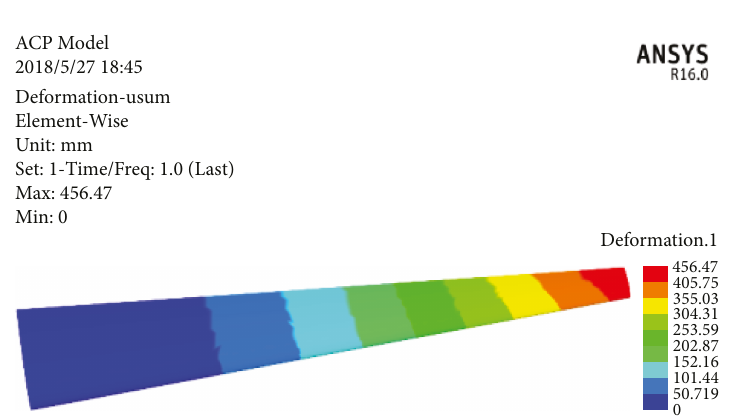
Figure 32: Deformation cloud diagram with the layer angle being 90 and 0.